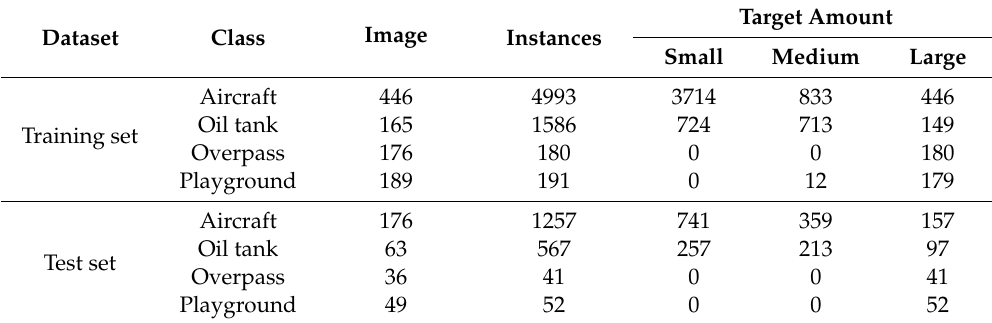
Table 7. Statistics table of RSOD.